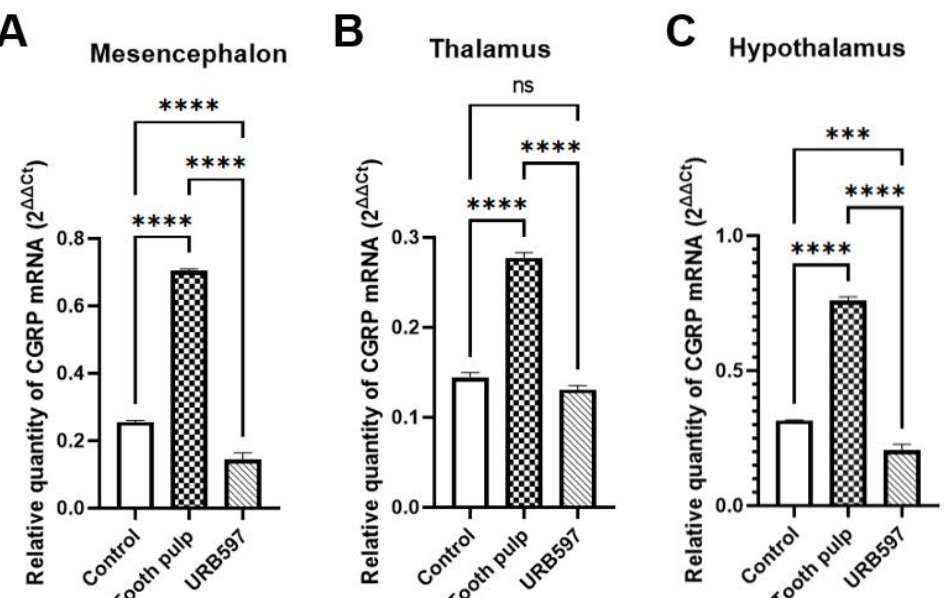
Figure 3. Quantitative RT-PCR analysis of CGRP mRNA expression in ( A ) mesencephalon, ( B ) thalamus and ( C ) hypothalamus induced by tooth pulp and URB597 treatment. The data represent mean ± SEM of 6 rats per group. Statistical significance was assessed using one-way ANOVA and a post hoc multiple comparison Tukey test. Asterisks denote significance level (*** p < 0.001, **** p < 0.0001, ns — not statistically significant).